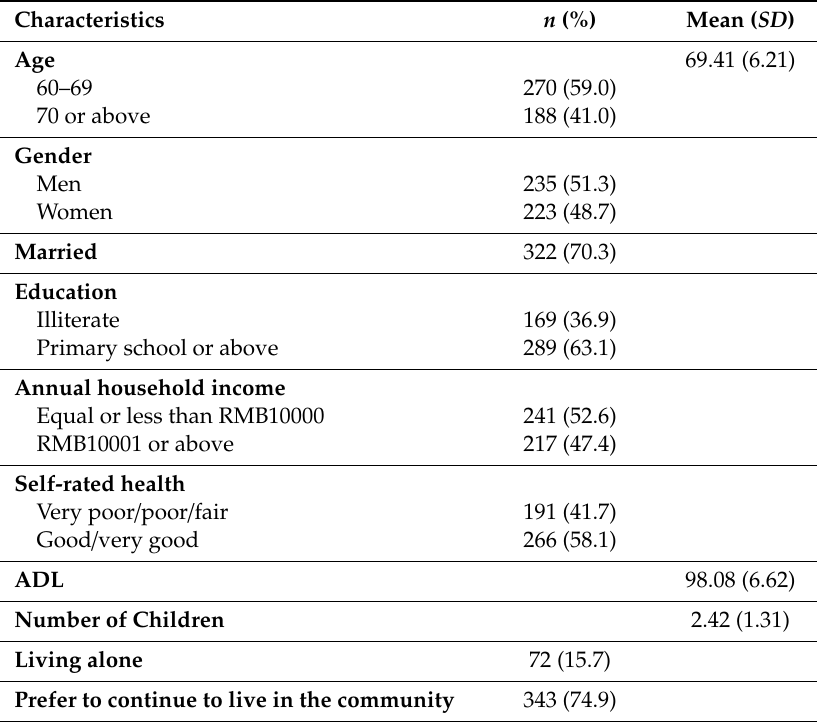
Table 1. Sample characteristics ( n =